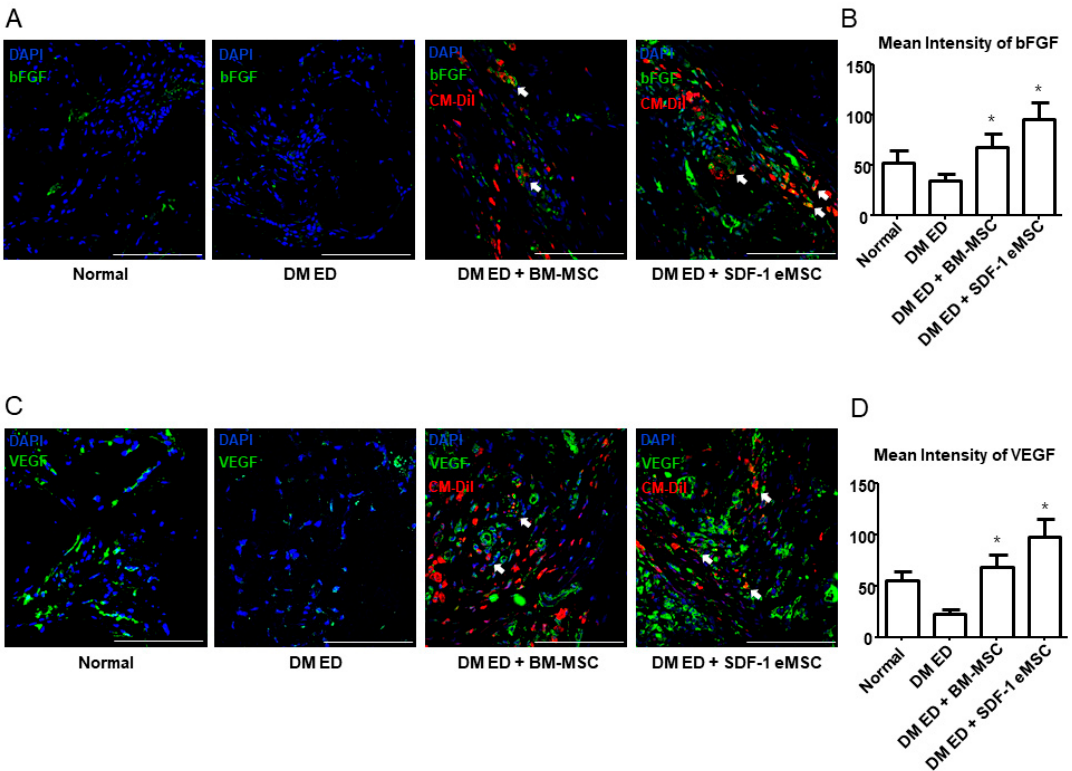
Figure 6. Representative images of bFGF and VEGF expression in the corpus cavernosum. ( A ) Representative images of bFGF staining for each group. Red indicates MSCs, green indicates bFGF, and blue shows cell nuclei. Arrow indicates bFGF released by MSCs. Scale bar: 100 µ m. Original magnification: × 200; ( B ) Mean intensity of bFGF expression. ( C ) Representative images of VEGF staining for each group. Red indicates MSCs, green indicates VEGF, and blue indicates cell nuclei. Arrow indicates VEGF released by MSCs. Scale bar: 100 µ m. Original magnification: × 200; ( D ) Mean intensity of VEGF expression. Each bar shows the mean value (standard deviation). * p < 0.05 compared with the DM ED group.